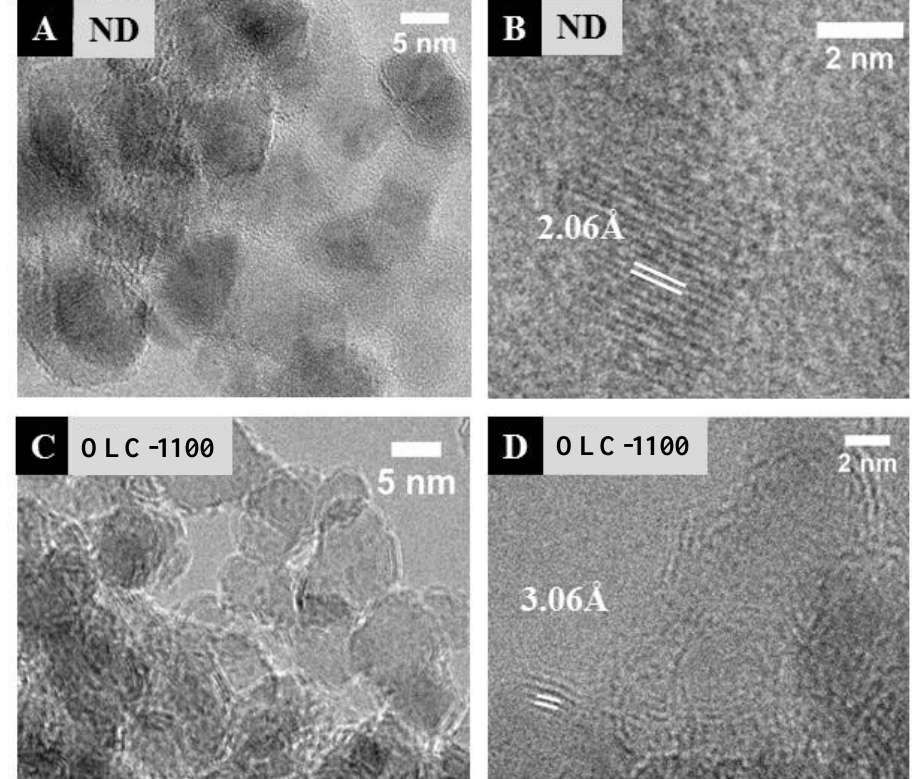
Figure 1. Transmission electron micrographs of pristine nanodiamonds ( A , B ) showing the lattice spacing of 2.06 Å corresponding to the plane {111} and the surrounding by amorphous carbon, and OLC (obtained after annealing of ND at 1100 ° C), ( C , D ) showing the presence of a diamond core surrounded by 3-5 graphitic shells and the lattice spacing of 3.06 Å corresponding to the plane {002}.